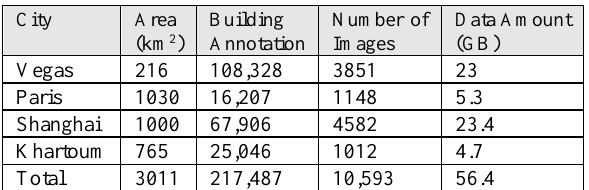
Table 5.1: Information of the dataset